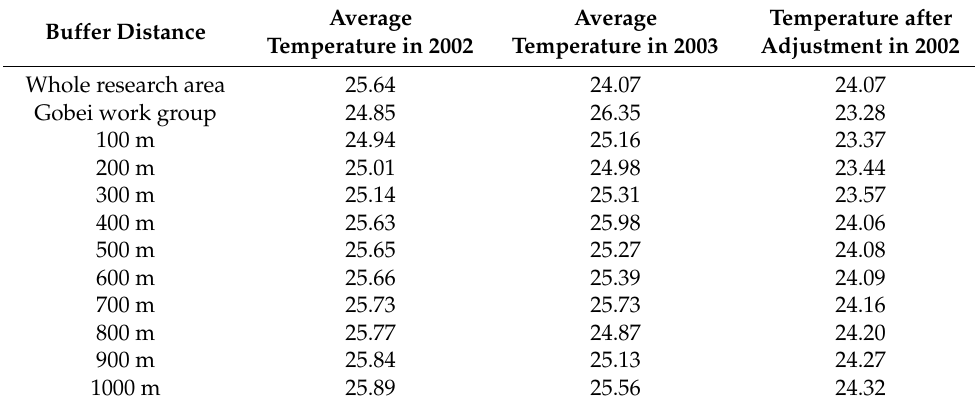
Table 3. Average surface temperature ( ◦ C) of the Gobei work group in the Hsinchu Irrigation Association. Average Average Temperature Buffer Distance Temperature in 2002